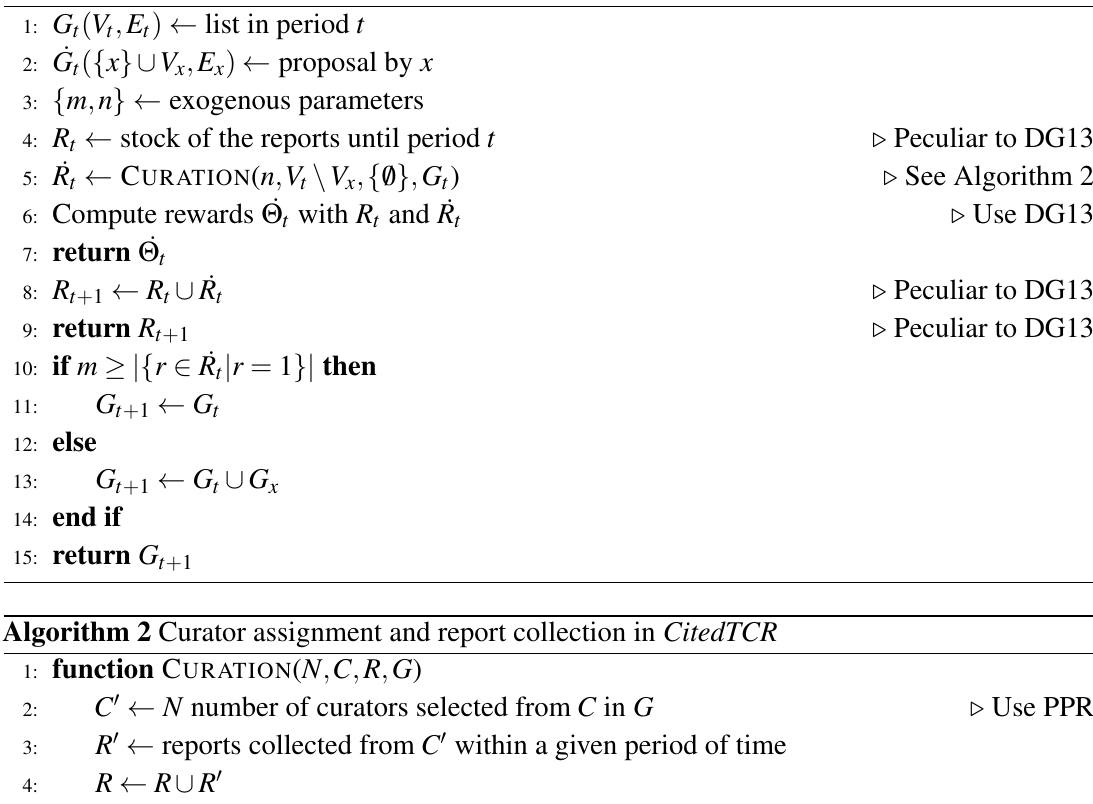
Algorithm 1 State transition in CitedTCR